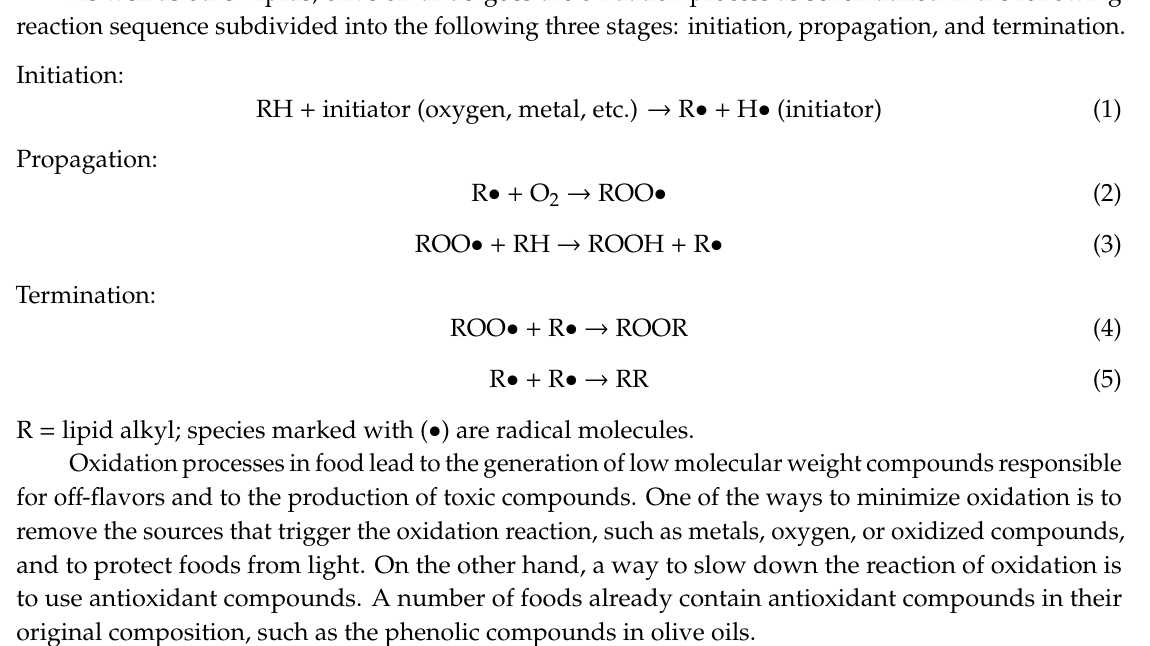
Table 2. Samples aspects and composition. Oil and oil + Span 80 are treated with an Ultra-turrax in order to supply them the same energy as the emulsion systems. Colloids Interfaces 2018 , 2 , x FOR PEER REVIEW